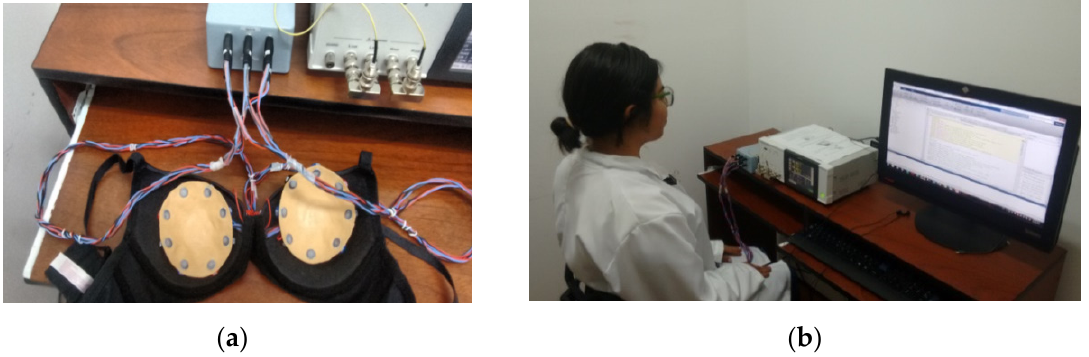
Figure 2. Bioimpedance measurement system: ( a ) designed latex cups within brassiere; ( b ) measuring participant’s breast bioimpedance.